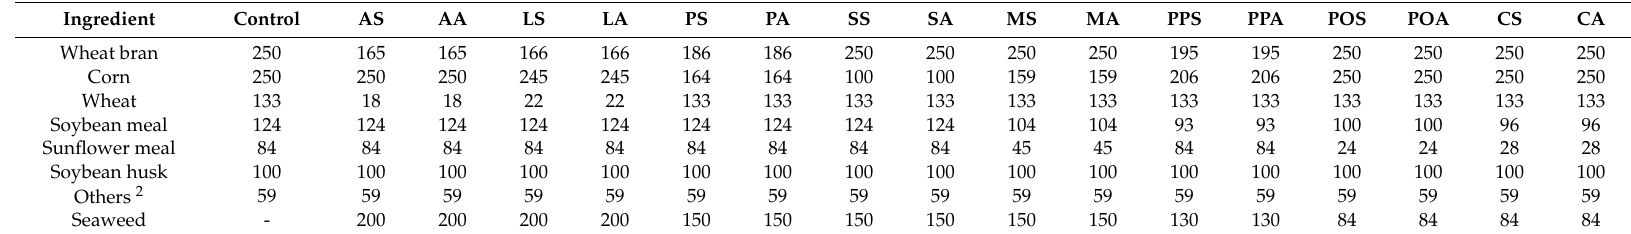
Table 1. Ingredient composition (g / kg fresh matter) of the experimental concentrates 1